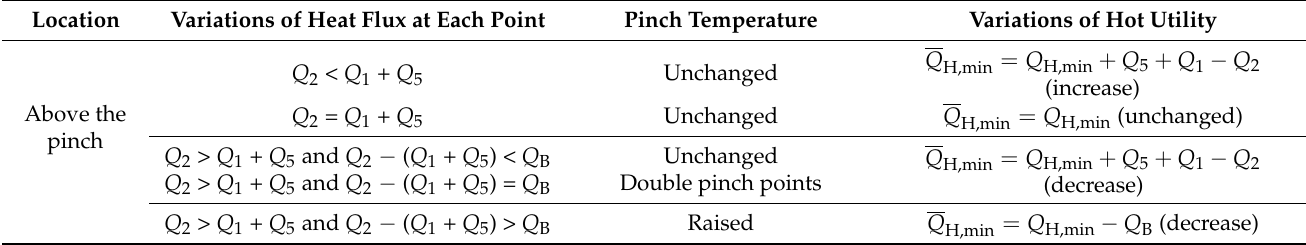
Table 2. Changes of the pinch temperature and hot utility for Case 2.